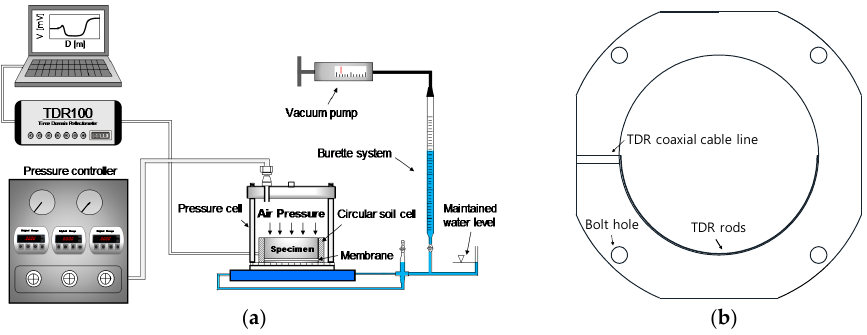
Figure 4. Schematic drawing of apparatus: ( a ) VPPE incorporated with the TDR system; ( b ) circular soil cell.